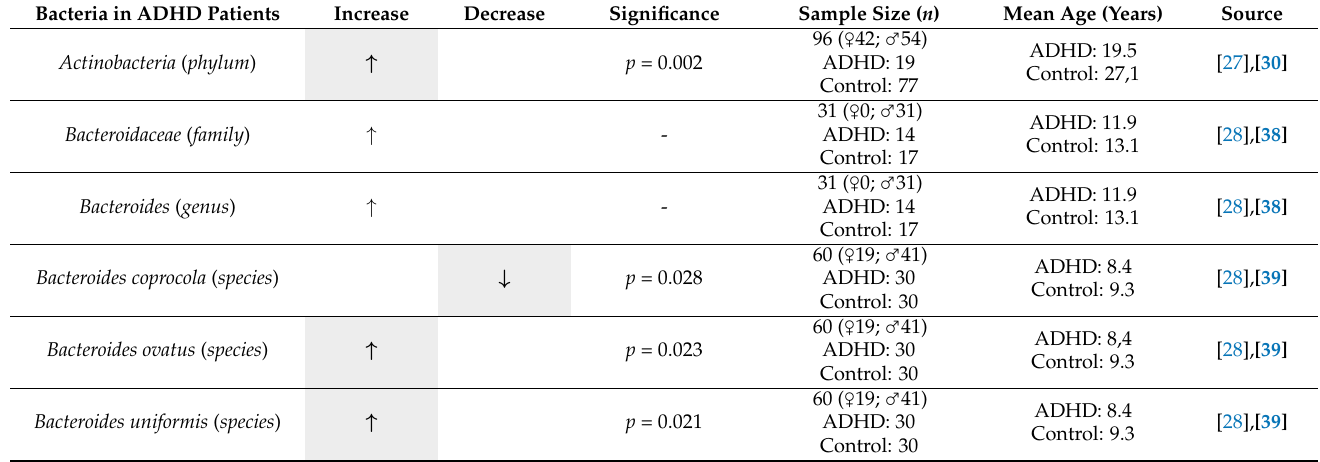
Table 2. Bacteria (with taxonomic level) that were found in higher ( ↑ ) or lower ( ↓ ) abundance in attention deficit hyperactivity disorder (ADHD) patients. Arrows of significant results in at least one study are represented with a grey background. ( p < 0.05 or LDA values > 2). “-” in the significance column indicate that no statements regarding the significance of the results were made in the corresponding studies. Empty cells mean that no significant differences could be identified. For the studies’ demographic characteristics, sample size and mean age were included. Sample size numbers are split into females and males for patients and healthy controls. The mean age is given for the patient group and the healthy control group, as a further breakdown for the gender groups was not consistently provided. The relevant source is shown in bold